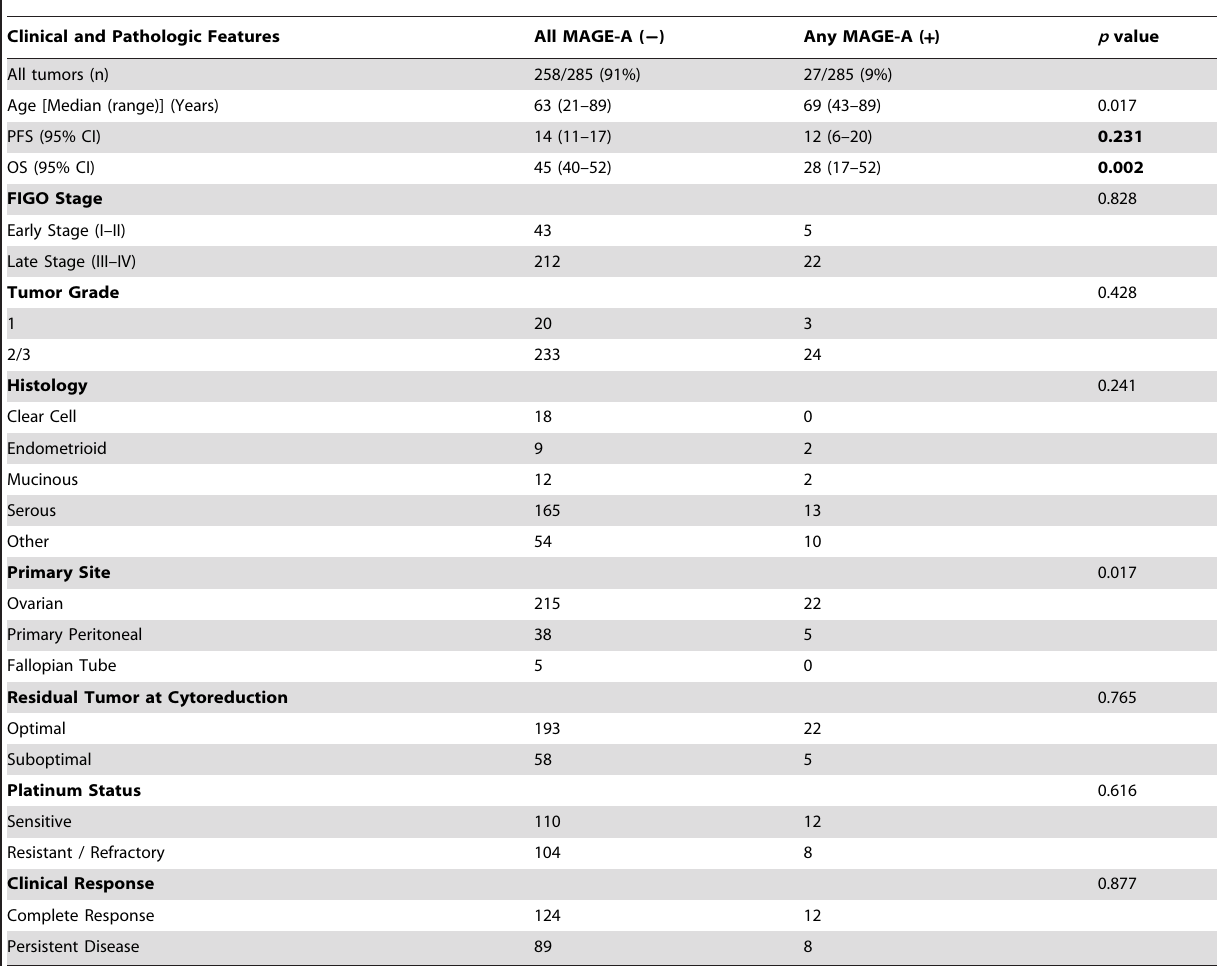
Table 4. Patient Characteristics by MAGE Serology.